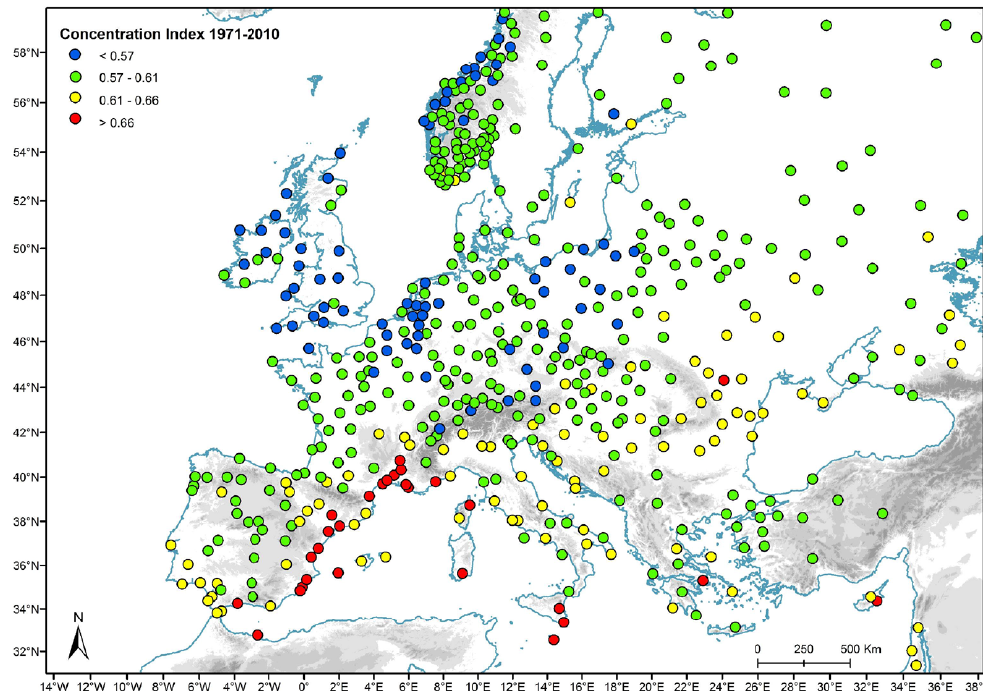
Fig. 3. Annual CI values distribution. Each colour corresponds to a different interval: CI values 0.56 or lower (blue dots), between 0.57 and 0.61 (green dots), between 0.62 and 0.66 (yellow dots), and 0.67 or higher (red dots).